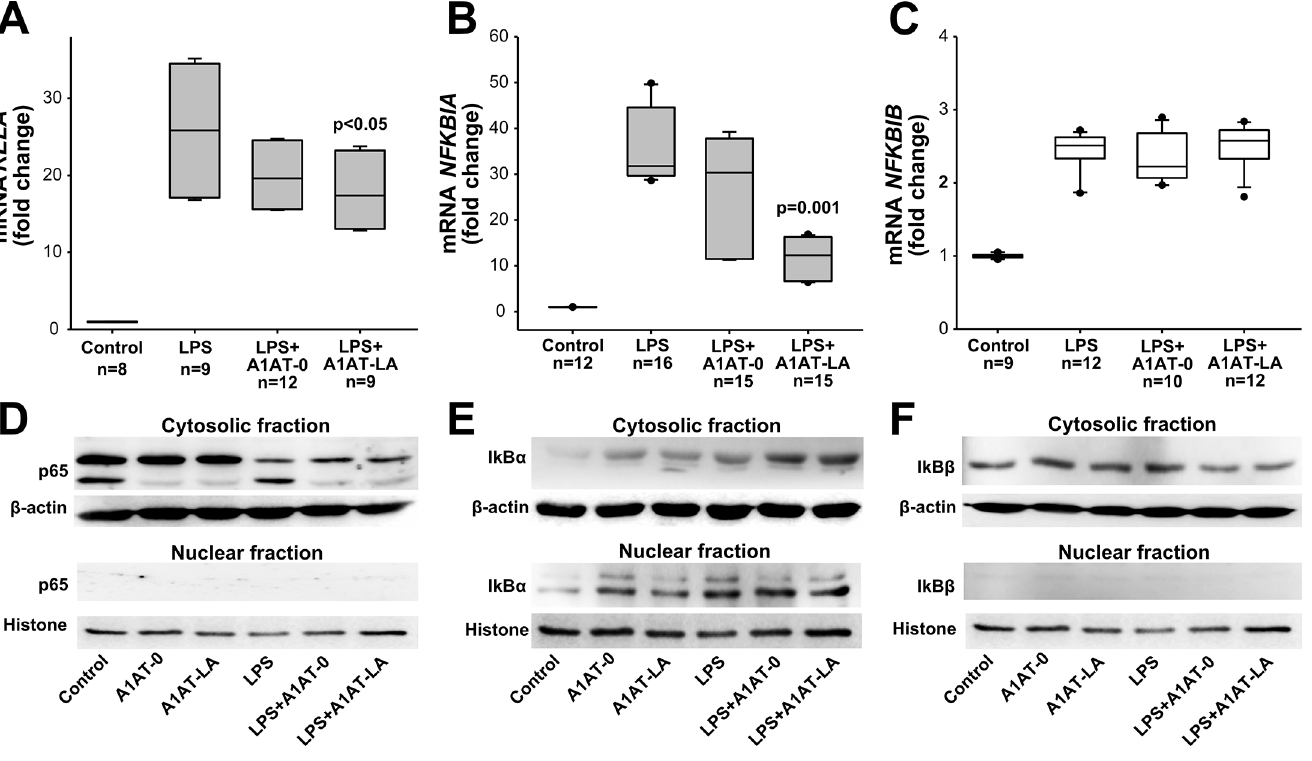
Figure 3. Effects of LPS and LPS/A1AT-0 and LPS/A1AT-LA on RelA /p65, NFKBIA /I κ B α and NFKBIB /I κ B β expression and protein levels. Human neutrophils (5 × 10 6 ) were incubated for 5 h in either medium alone or medium containing LPS (20 ng/mL) in the absence or presence of A1AT-0 (1 mg/mL) or A1AT-LA (1 mg/mL). mRNA expression of RelA /p65 (A), NFKBIA /I κ B α (B) and NFKBIA /I κ B β (C) genes was